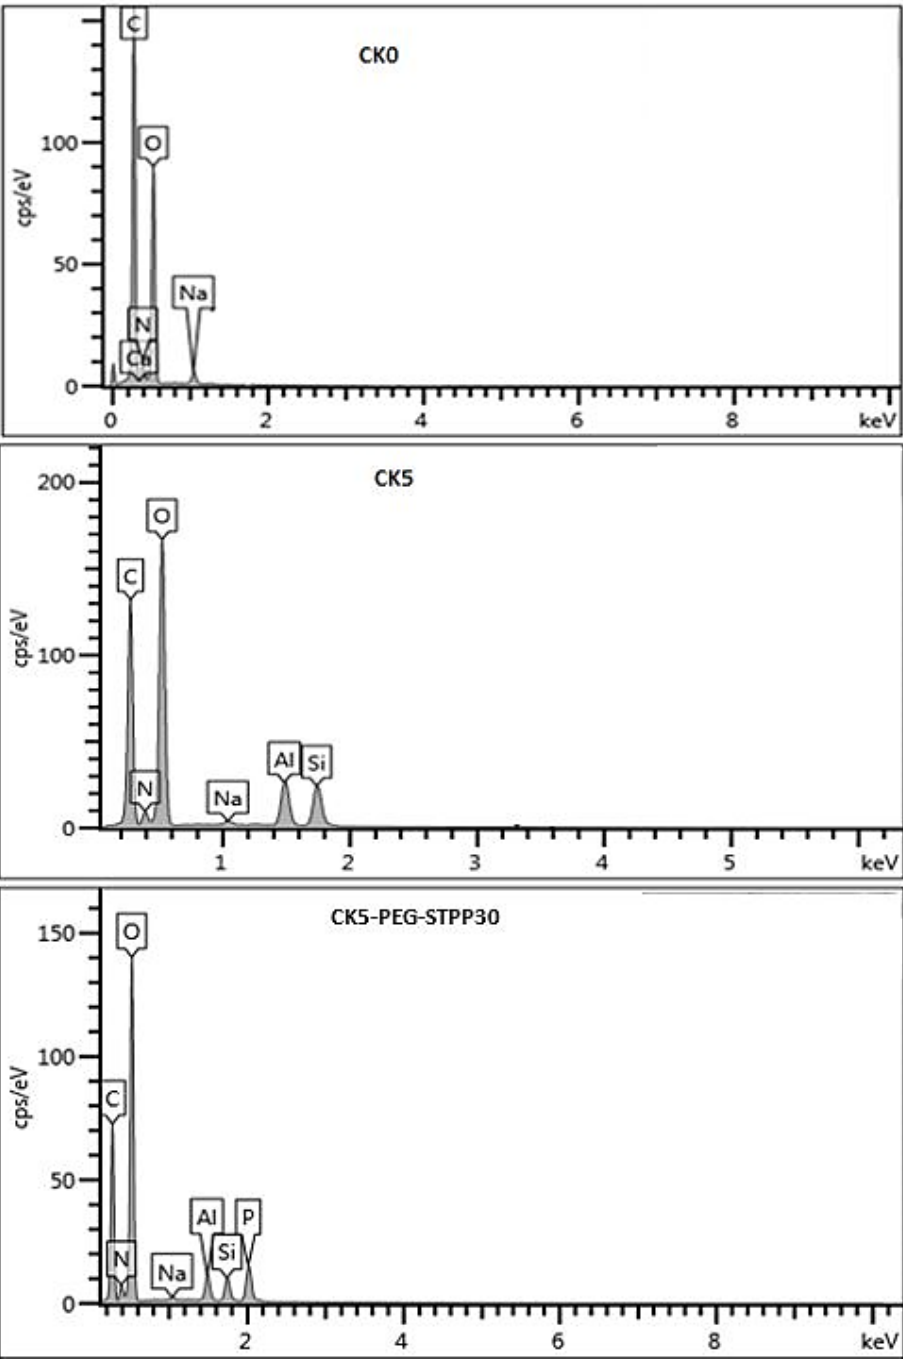
Figure 5. EDX microanalysis of pristine chitosan membrane (CK0), chitosan – kaolin composite membrane (CK5) and STPP cross-linked membrane (CK5-PEG-STPP30).